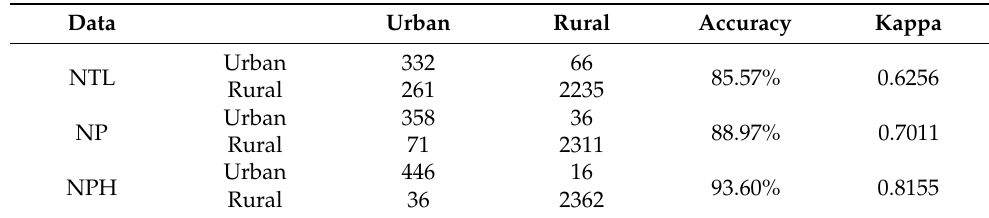
Table 3. Confusion